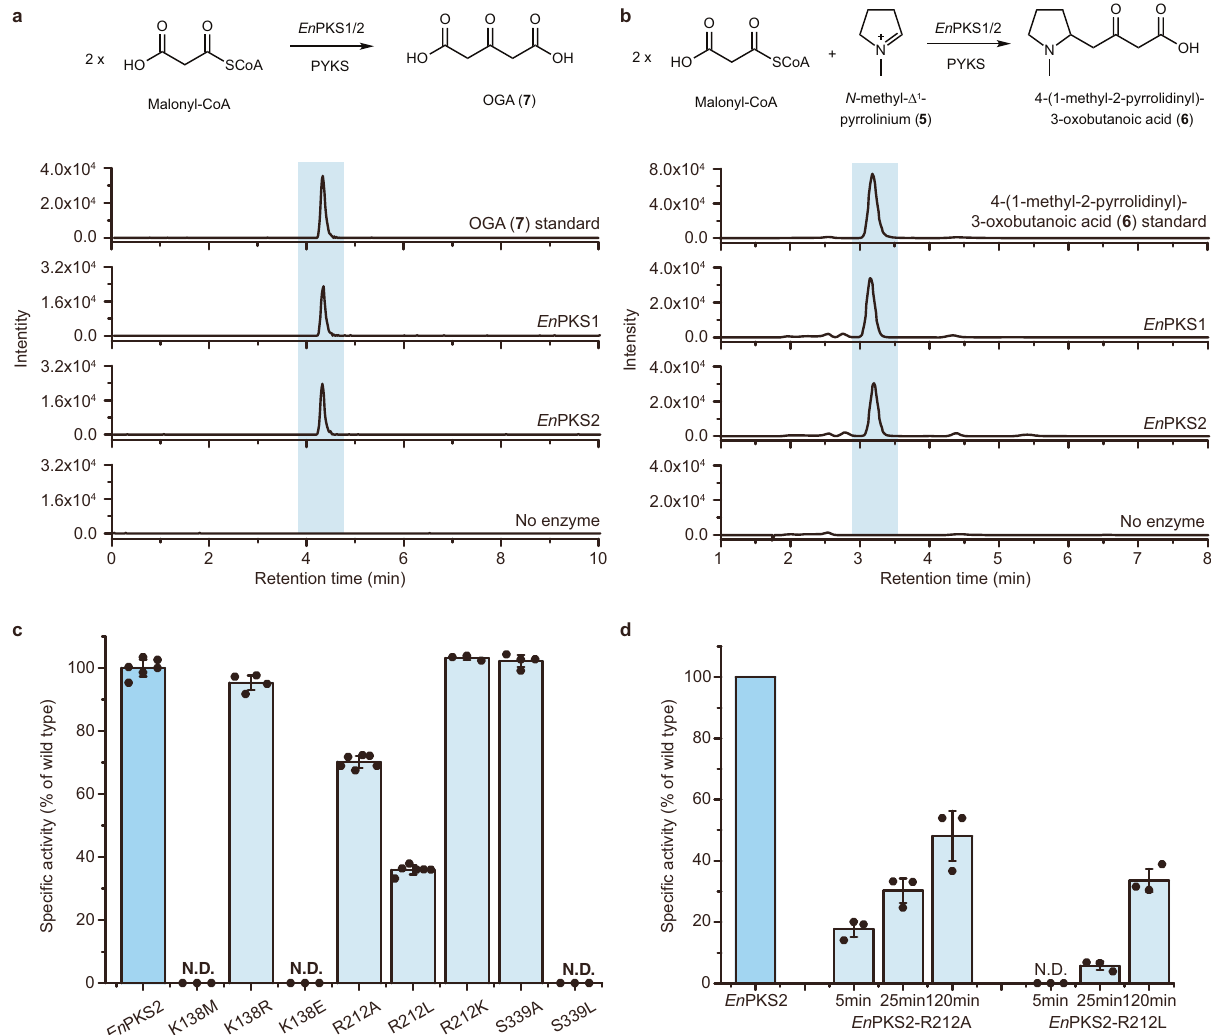
Fig. 2 | Identi fi cation of En PKSs. a LC-MS chromatograms at [M+Na] + =169.0107 ofOGA( 7 )inenzymaticreactionsusingmalonyl-CoAassubstrate.Arepresentative result of n =3 independent experiments is shown. b LC-MS chromatograms at [M+H] + =186of 6 inenzymaticreactionsusingmalonyl-CoAand 5 assubstrates.A representative result of n =3 independent experiments is shown. c Production of OGA( 7 )catalyzedbywildtype En PKS2oritsvariantsusing0.5mMmalonyl-CoAas